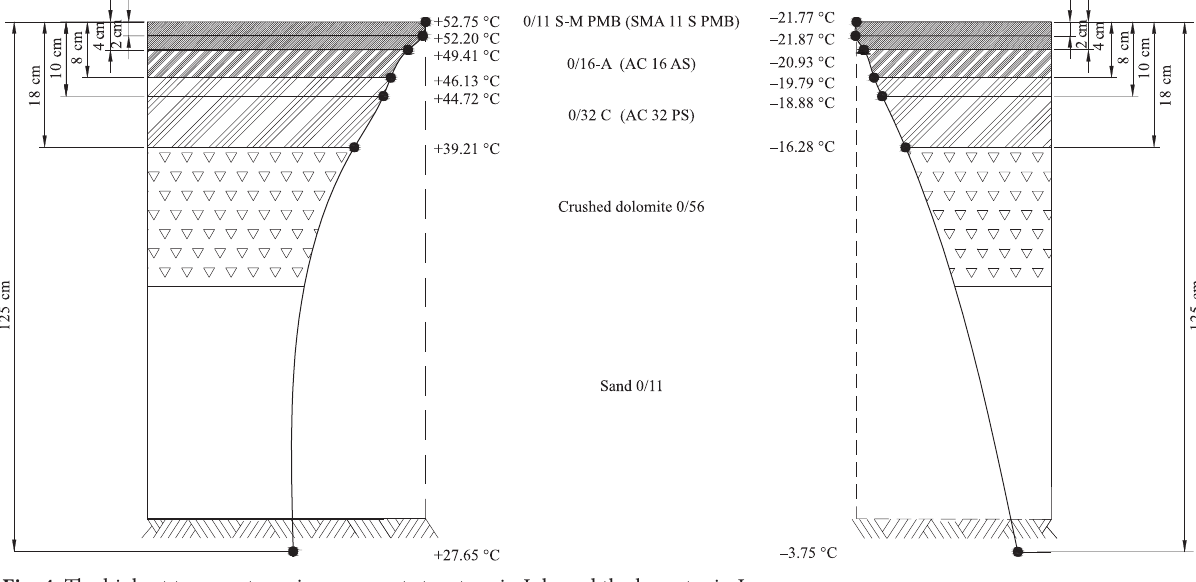
Fig. 4. The highest temperatures in pavement structure in July and the lowest – in January